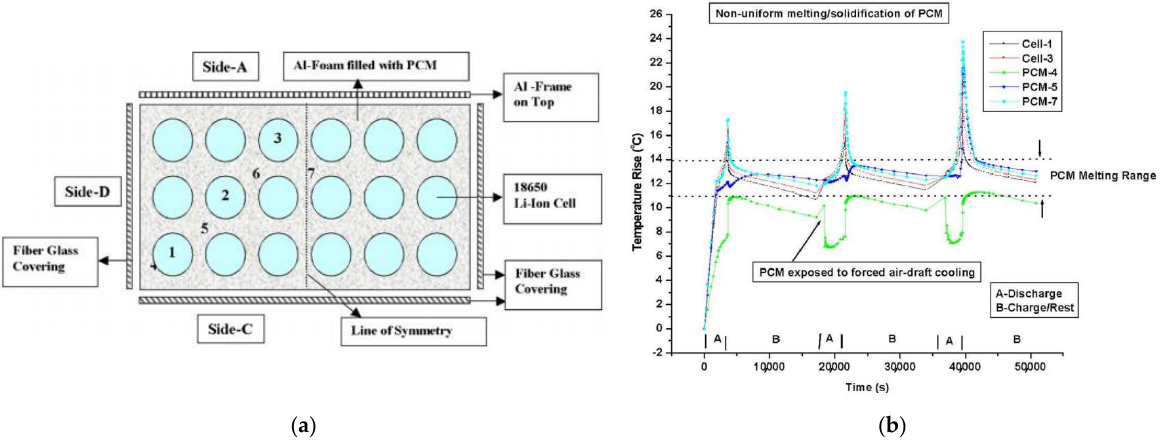
Figure 22. ( a ) Li-ion battery cell filled with PCM. ( b ) Temperature rise of Li-ion cells and three different PCMS settings. Reprinted with permission from [142]. Copyright 2004 Elsevier. Table 5. Recent developments of PCM-based battery thermal management